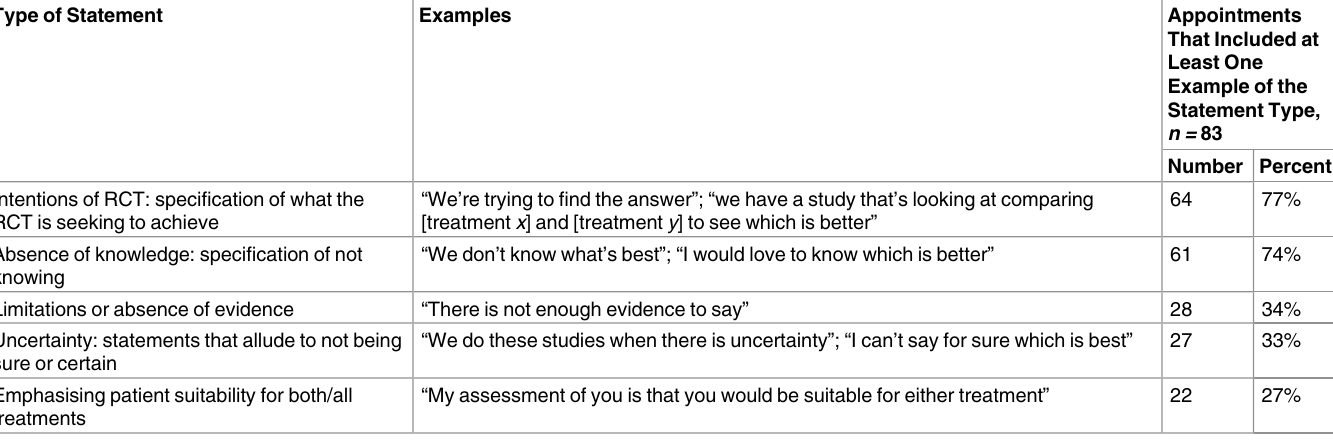
Table 2. Clinicians’ descriptions of the concept of equipoise to patients during RCT recruitment